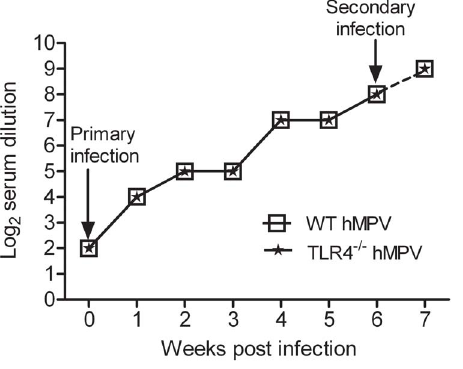
Figure 5. Induction of hMPV-specific neutralizing antibodies in the absence of TLR4. TLR4 2 / 2 and WT mice were infected with hMPV and sacrificed weekly to determine antibody titers by a plaque reduction neutralization assay. The lower detection limit for this assay is 2 log 2 serum dilution. At 6 weeks p.i. mice were challenged with hMPV and neutralizing antibody titers were determined 1 week later. Data are expressed as mean of four mice/group and represents one of two independent